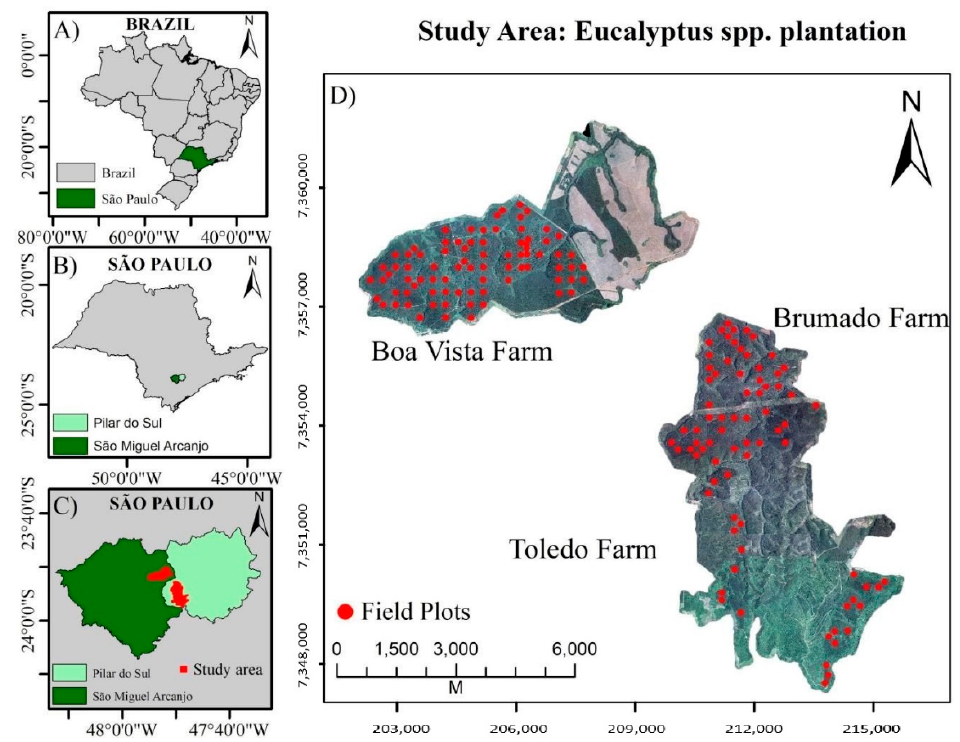
Figure 1. Location map of study area and plots. ( A ) Brazil and S ã o Paulo State, ( B ) S ã o Paulo State and the municipalities of Pilar do Sul, and S ã o Miguel Arcanjo, ( C ) study area within the municipalities of Pilar do Sul and S ã o Miguel Arcanjo, and ( D ) 158 circular plots of 400 m 2 each.